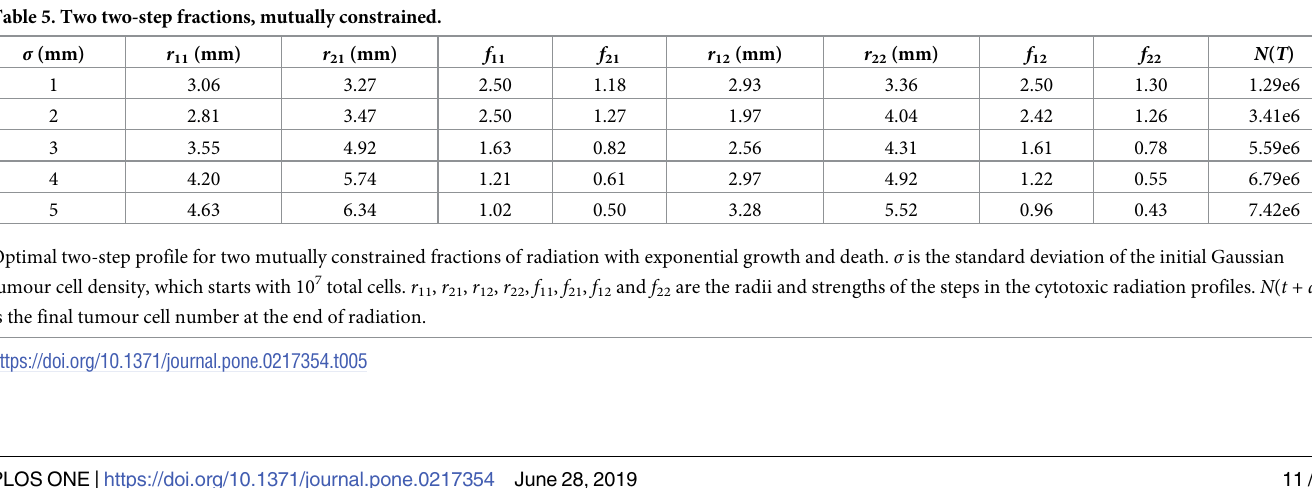
D4: Two fractions with overall constraint. As a final example within this class, with non- diffusive exponential growth between the two fractions, we consider the case when the overall dose is constrained, i.e. as